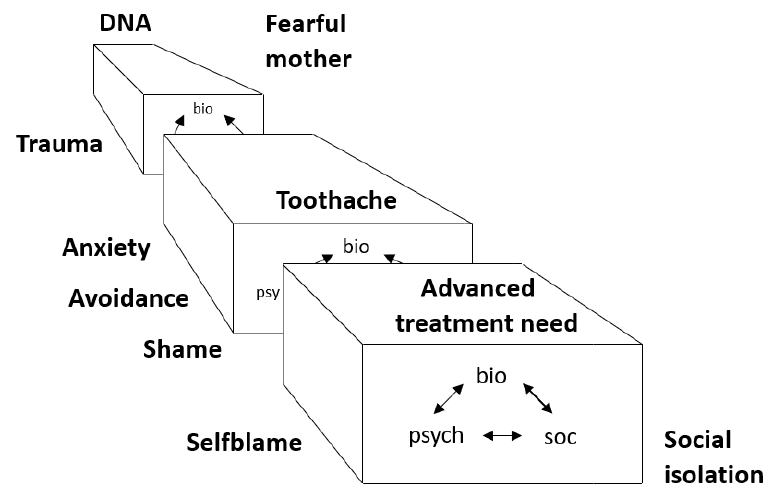
Figure 1. Intuitive analysis of the development of dental anxiety [1].